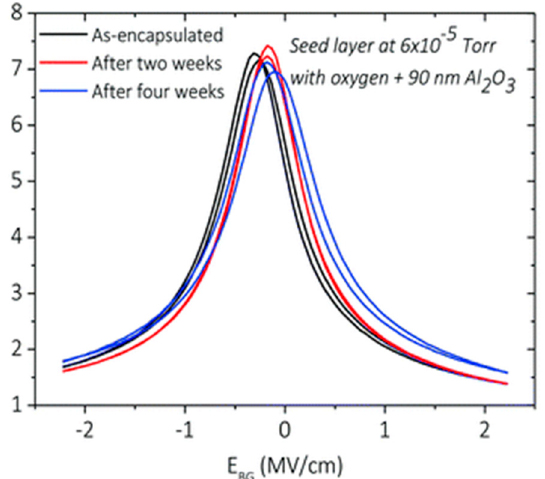
Figure 17. Endurance of electrical properties of encapsulated GFET measured over several weeks in ambient conditions (reproduced from [61] with permission of the Royal Society of Chemistry). The reproducibility in the characteristics is very important in photon counting applications.